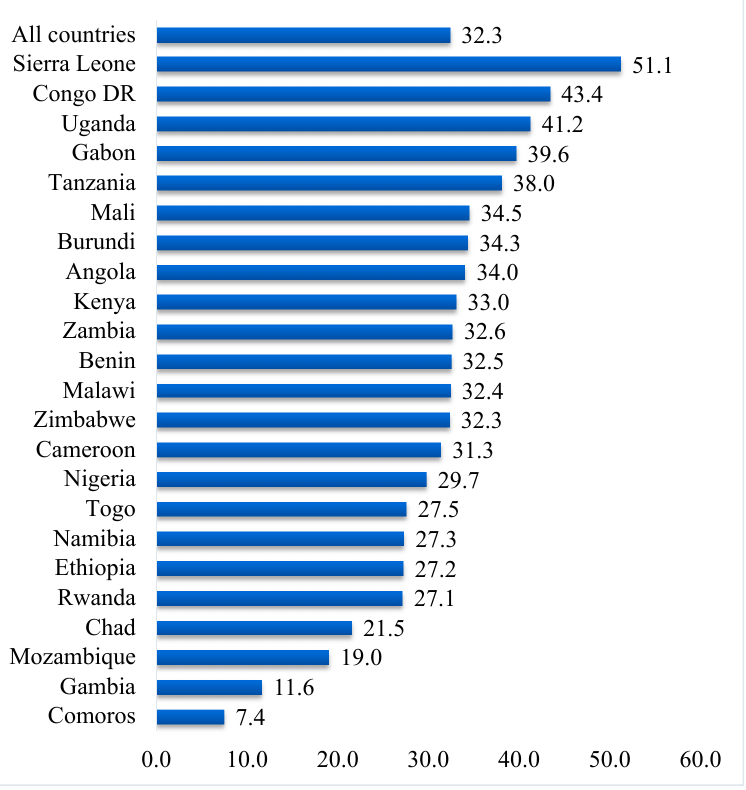
Figure 1. Prevalence of past-year experience of intimate partner violence (%).